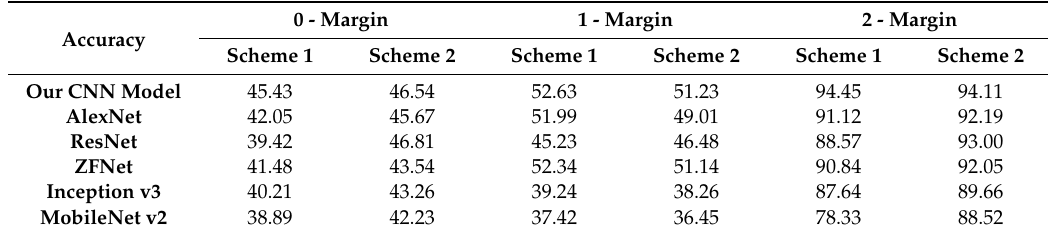
Table 7. Accuracy comparison for 0, 1 and 2 margins for CNN application models trained on RSSI